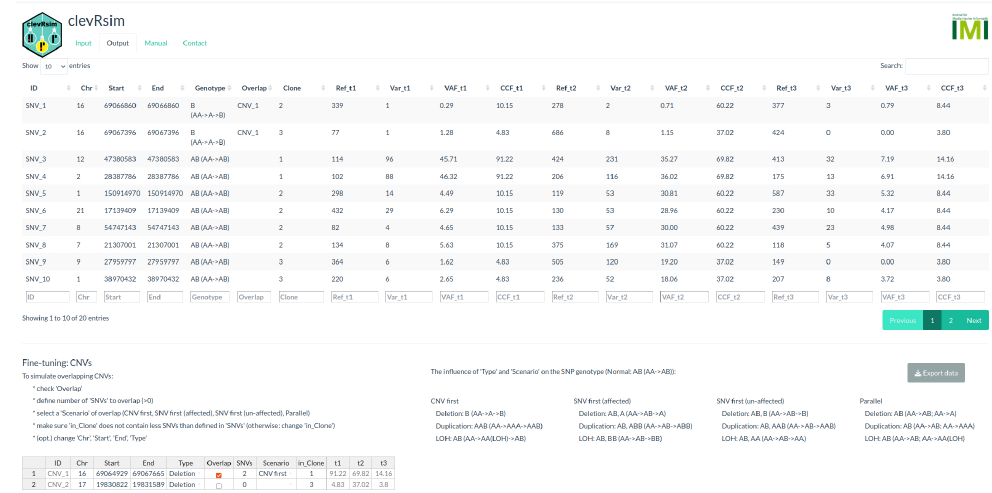
Figure A3. Exemplary simulation generated using clevRsim. When executing a simulation, the variant calls are available in the output panel. Information on basic and advanced call characteristics is provided in addition to the number of reference reads, variant reads, VAF, and CCF for every simu- lated time points. Additionally, an option for fine-tuning CNVs is displayed. Call characteristics can be changed, CNVs added and/or deleted, and the overlap of CNVs and SNVs defined. Subsequently, clonal evolution is updated by clicking ‘Update simulation’.